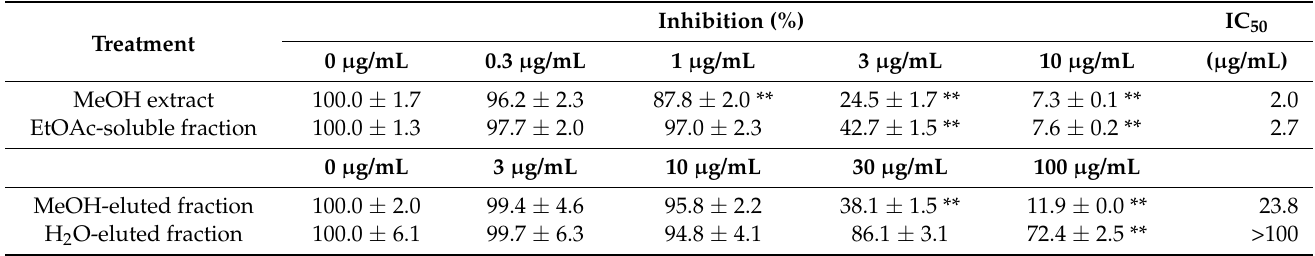
Table 1. Anti-proliferative effects of the methanol extract of M. siamensis flower and its fractions against LNCaP